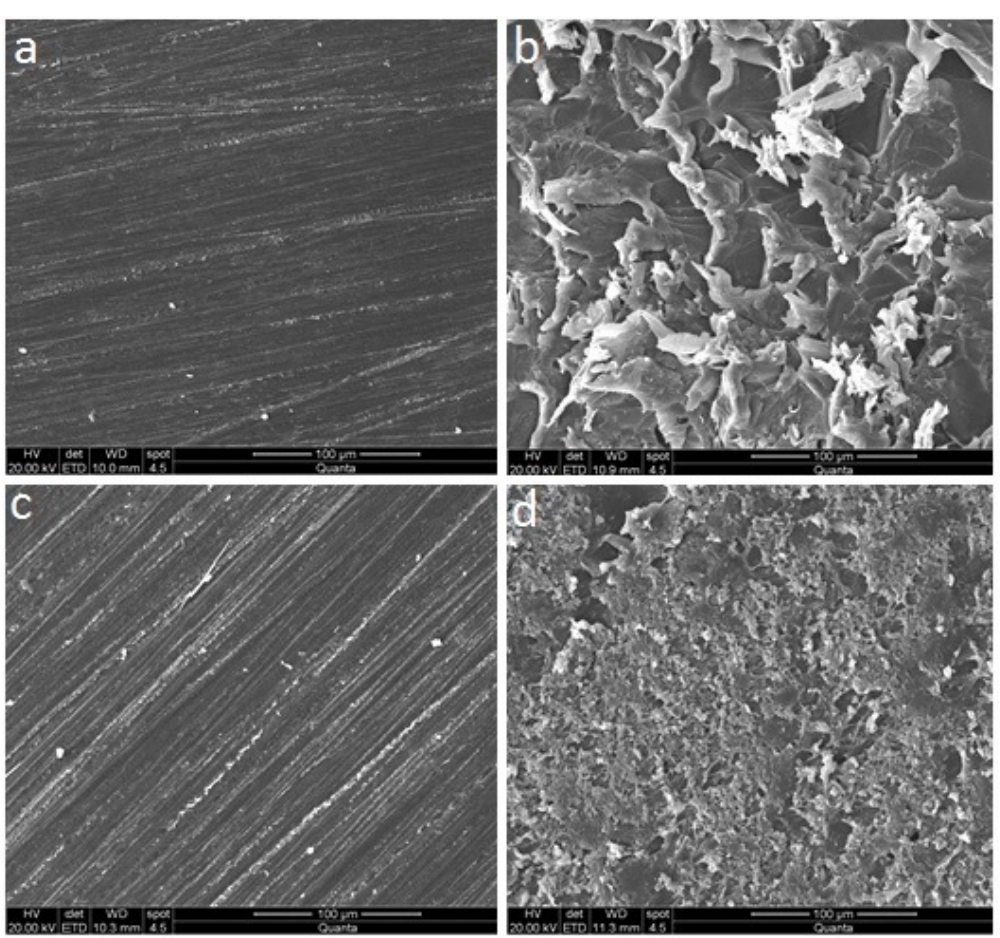
Figure 3. Scanning electron microscopy micrographs of the control and surface treated specimen groups before relining; ( a ) PMMA-C, ( b ) PMMA-S, ( c ) CAD/CAM-C, and ( d ) CAD/CAM-S.